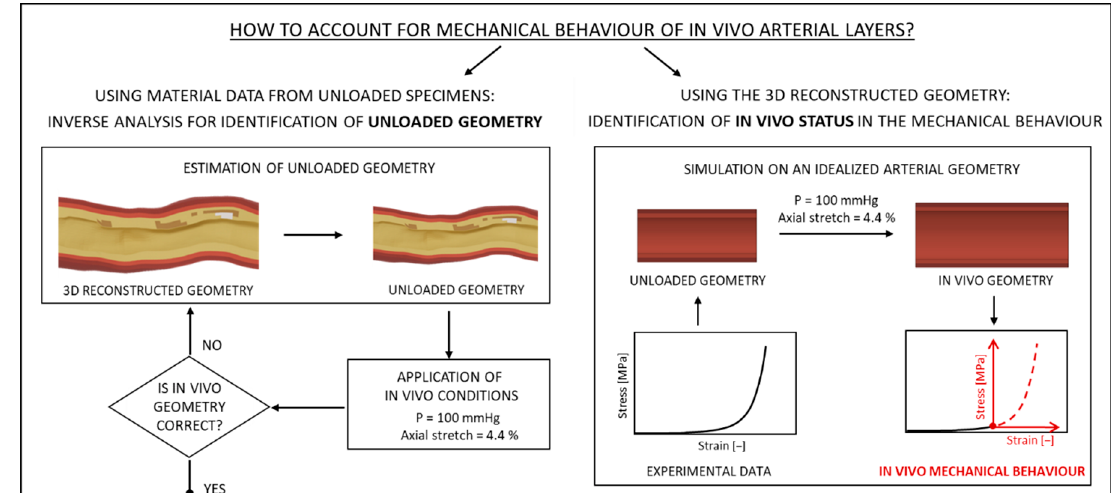
Figure 2. Schematic representation of two potential methods to account for the mechanical behavior of in vivo arterial layers as the experimental data to be associated with the reconstructed in vivo geometry are derived from testing unloaded specimens. On the left is shown a simplified scheme describing the rationale for identifying the unloaded geometry to be used with the experimental material data: by inverse analysis, the unloaded geometry is iteratively estimated from the geometry reconstructed from the in vivo images. On the right, an alternative, simpler method is proposed: through simulations on an idealized arterial geometry of the artery, the working point corresponding to the in vivo status was identified in the experimental material data for the extrapolation of the in vivo mechanical behavior.